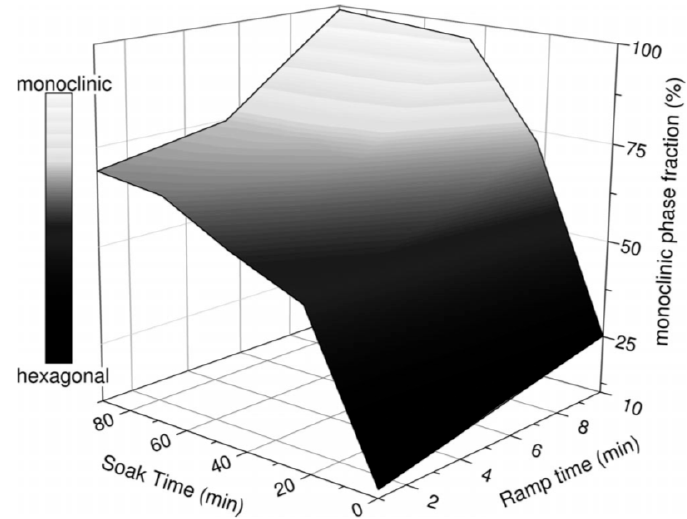
Figure 13. Contour plot of the conversion from the hexagonal phase to the monoclinic phase of Eu-doped (Ba 1 − x Sr x )Al 2 Si 2 O 8 materials. The ramp time and soak time (in minutes) of the microwave reaction are presented on the x and y axes, respectively, while the refined phase fractions are presented on the z axis [112]. Copyright © 2014, with permission from John Wiley and Sons.